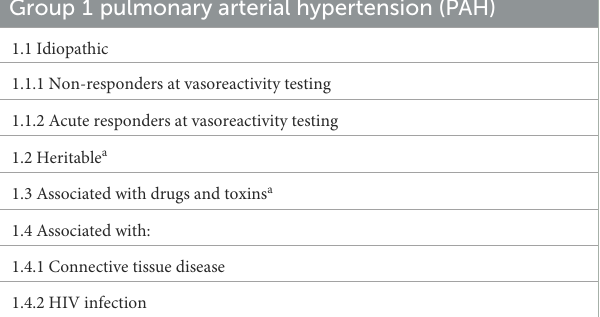
TABLE 1 2022 ESC clinical classification of pulmonary hypertension